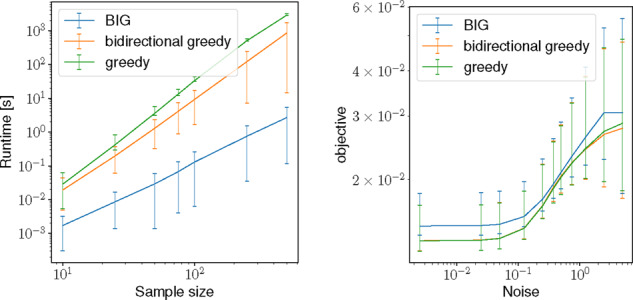
Comparison of three submodular optimization algorithms on a simulation dataset consisting of five ground truth prototype representatives (shown in red in Fig. 1). Left: the runtime in seconds (y-axis) when varying the number of replicates per prototype (x-axis). Right: the value of the objective function (y-axis) varying the uniform noise added to the prototype (x-axis)